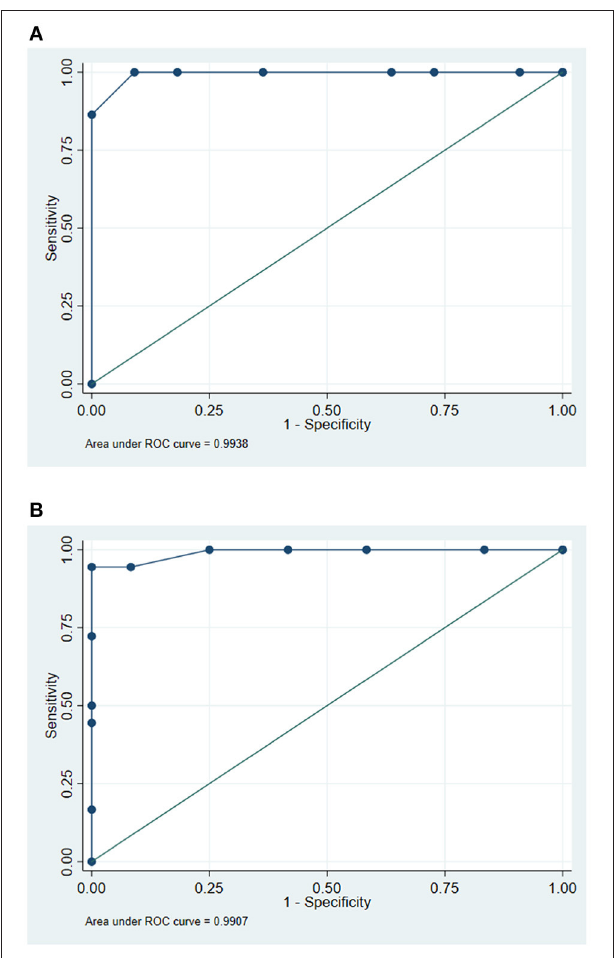
FIGURE 3 | Receiver-operating characteristic (ROC) curve for the Peruvian version of the Rowland Universal Dementia Assessment Scale (RUDAS-PE) for discrimination between mild cognitive impairment (MCI) and dementia groups. Chuquibambilla, Junín. (B) Receiver-operating characteristic (ROC) curve for the Peruvian version of the Rowland Universal Dementia Assessment Scale (RUDAS-PE) for discrimination between mild cognitive impairment (MCI) and dementia groups. Santa Clotilde,